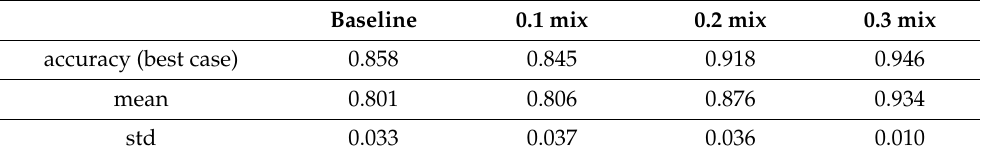
Table 4. Accuracy values obtained with different balanced dataset modifications.